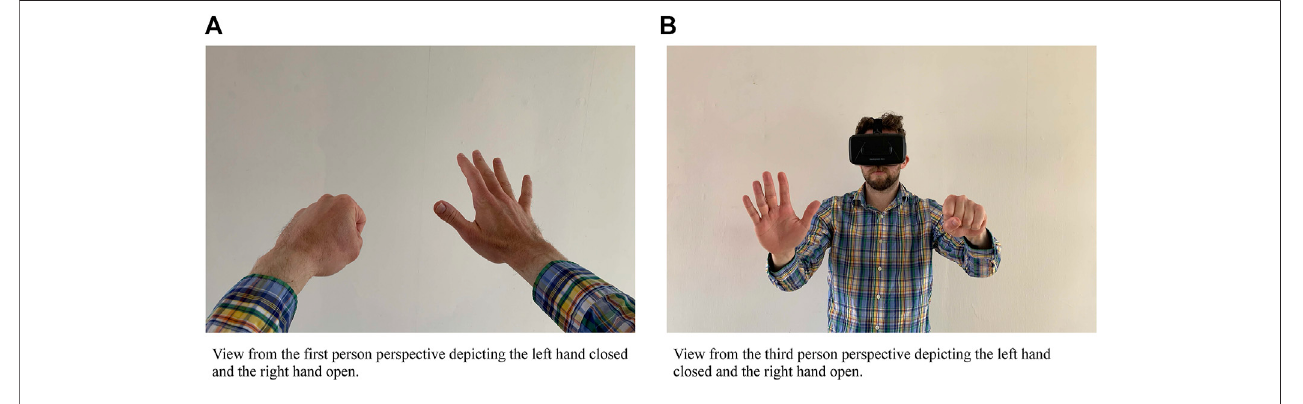
FIGURE 1 | Visualization for both experimental